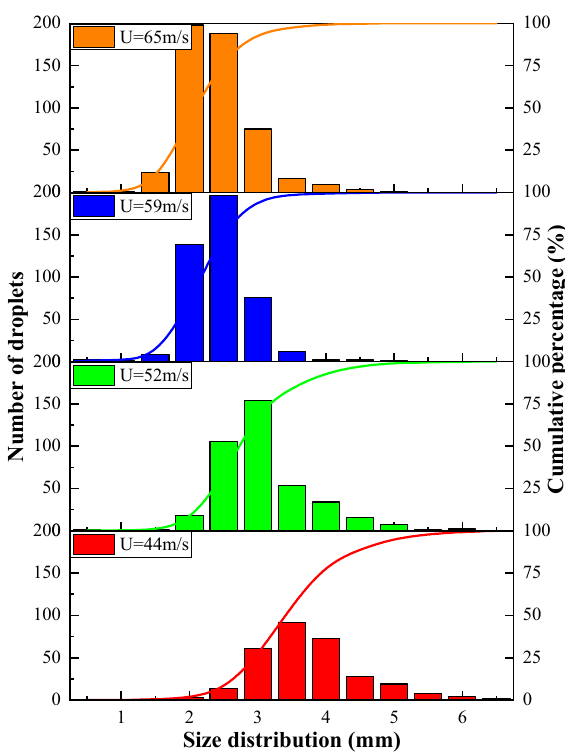
Figure 2. Size distributions of the emulsified droplets against gas velocities.